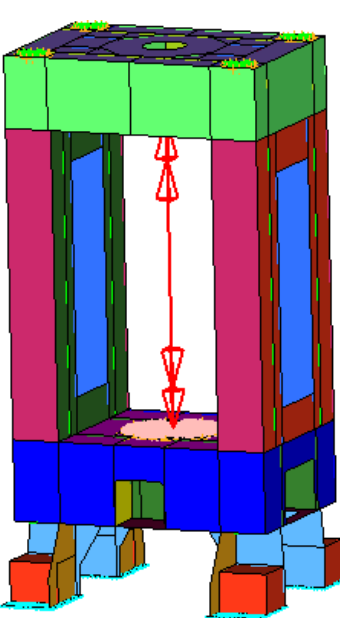
Figure 23. Size optimization